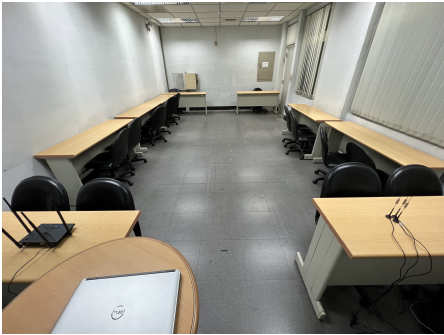
Figure 3. The university discussion room where the experiments were conducted. The photo shows the experimental setting of a single WiFi link. The Tx and Rx are placed on separate desks (0.75 m high).